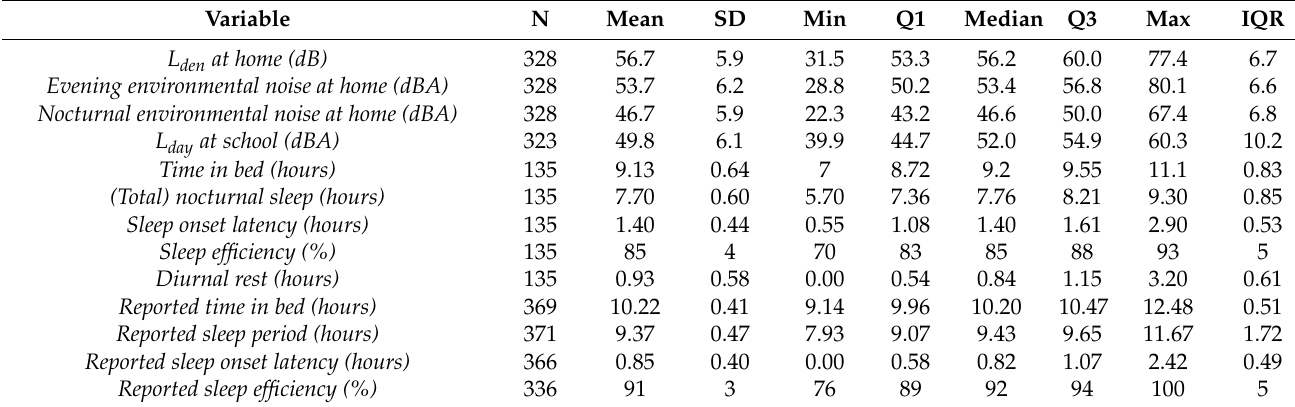
Table 1. Description and distribution of environmental exposure and response variables. Sample size (N), mean, standard deviation (SD), minimum and maximum values and quartiles are given for each